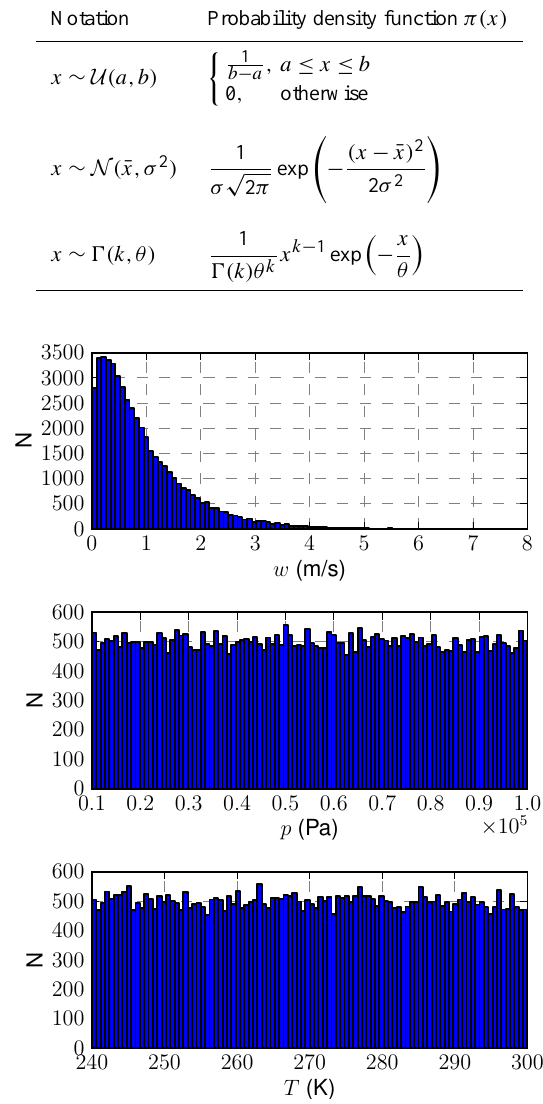
Table 4. The notations used for the probability distributions and their probability density functions. 0(k) denotes the Gamma func- tion.